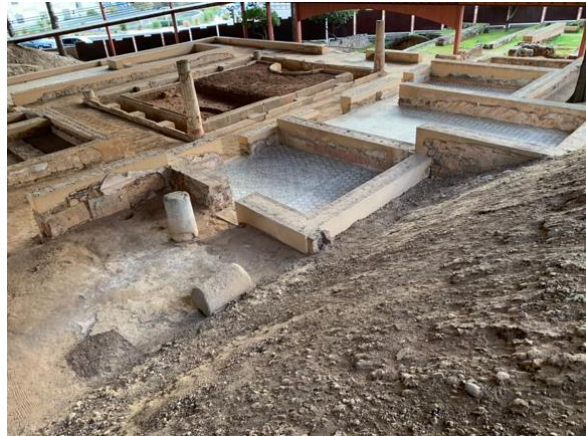
Figure 7. Archaeological remains of the rooms and mosaics in the monumental complex of the "Casa del Mitreo", in the city of Mérida (Spain).